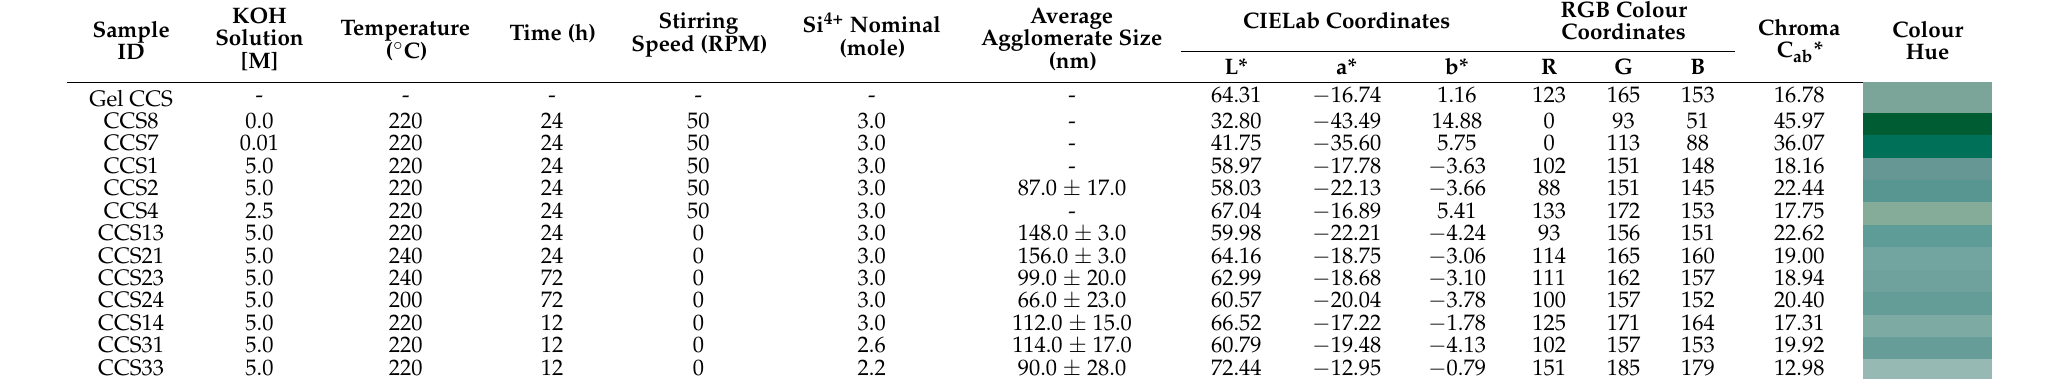
Table 2. Summaries of the particle sizes, CIE-L*a*b* values, chroma, RGB parameters, and colour of Ca 3 Cr 2 Si 3 O 12 pigments prepared under stirred and static conditions; at different temperatures, reaction intervals, Si 4+ deficiency with respect to the nominal concentration; and alkaline KOH media with different